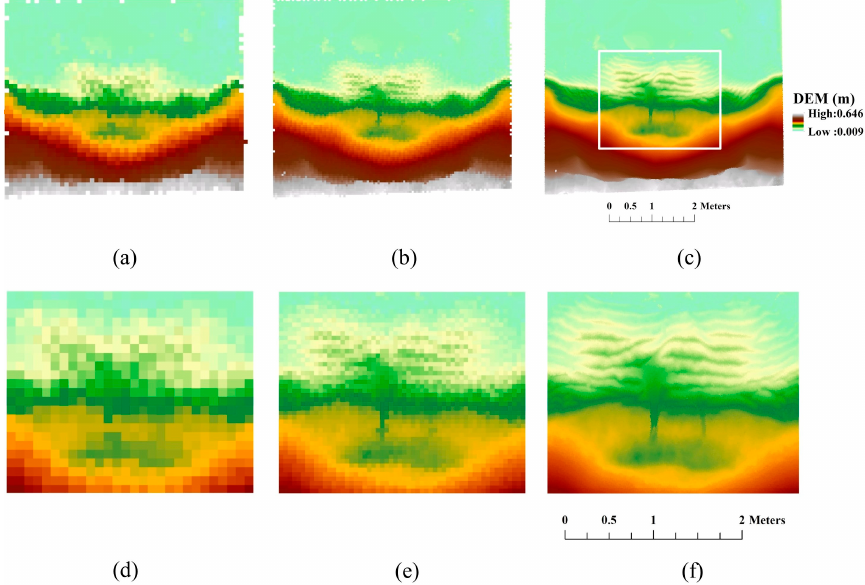
Figure 4. Beach morphological models having resolutions of 10 cm ( a ), 5 cm ( b ) and 1 cm ( c ) with corresponding highlighted areas of erosion and deposition ( d ), ( e ), and ( f ) showing clarity of the area with the most sediment dynamics.